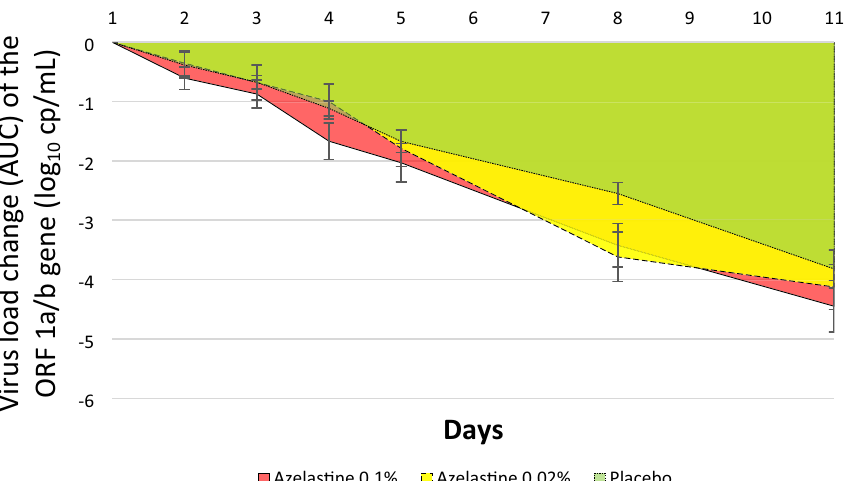
Figure 4. Area under the curve (AUC) reflecting changes in viral copy numbers (log 10 cp/mL) from baseline (day 1) over time (until day 11) based on the ORF 1a/b gene (ITT analysis set). The overall AUC of the